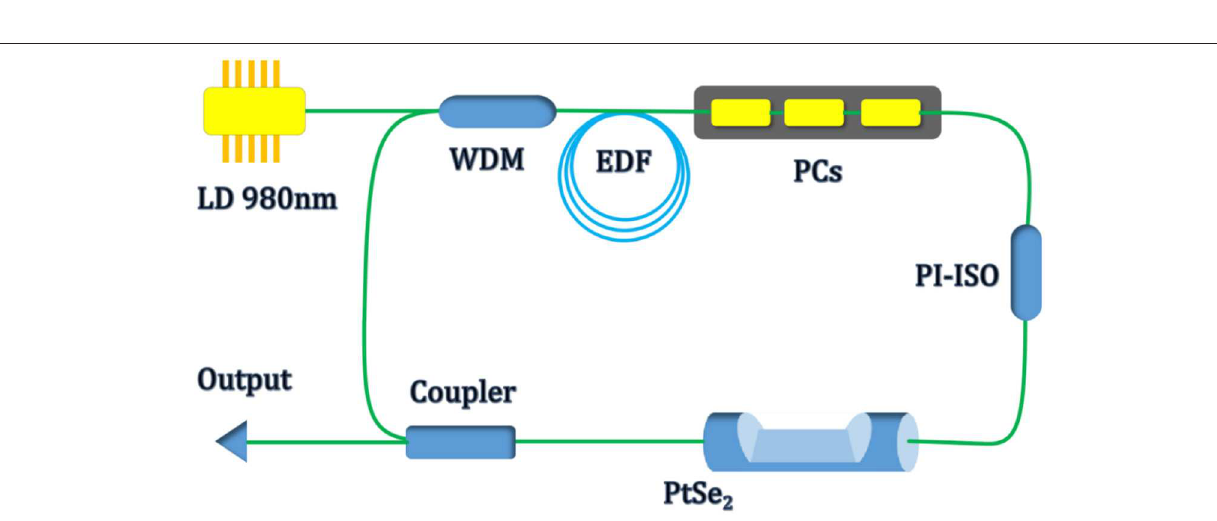
FIGURE 2 | Experimental setup of the mode-locked Er-doped fiber laser.